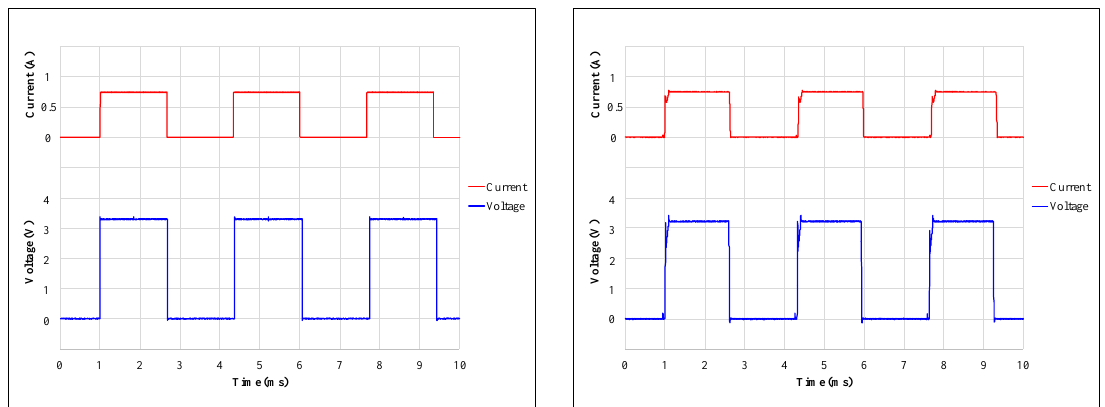
Figure 24. Voltage and current signals of the motor at 900 rpm with wire-driven ( left ) and wireless- driven ( right ) conditions.